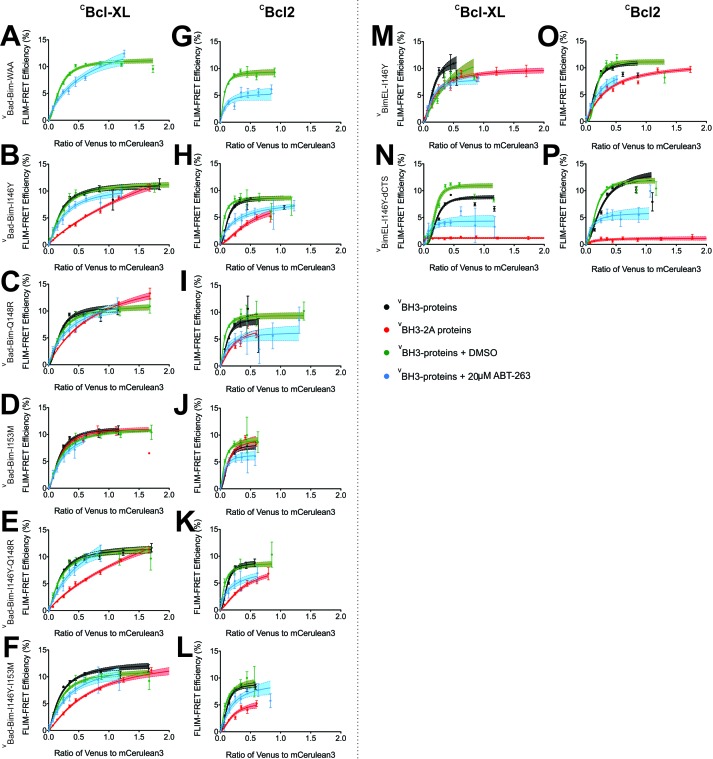
The h0 and h1 residues in the Bim BH3 region contribute to the resistance of Bcl-XL:Bim and Bcl-2:Bim complexes to ABT-263.(A–L) Binding of VBad-Bim chimeric proteins to CBcl-XL (left) and CBcl-2 (right) in MCF-7 cells. The VBad-Bim chimeric proteins are comprised of VBad with the BH3 region replaced with the corresponding region from Bim. Additional point mutations in the Bim BH3 region are indicated to the left of each pair of panels. (M–P) Impact of I146 on the binding of VBimEL or VBimEL-dCTS to CBcl-XL (left) and CBcl-2 (right) in MCF-7 cells. Additional point mutations in VBimEL are indicated to the left of each pair of panels. The binding curves illustrate the extent of binding of untreated (black) and DMSO treated (green) controls, cells treated with 20 μM ABT-263 (blue) or additional BH3-2A mutation (red). Data points in FLIM-FRET binding curves correspond to the average FLIM-FRET efficiency for binned data (20 < cells/bin < 3,000). Error bars, SEM; shadowed area, 95% confidence interval for the best fit of the model to the data.10.7554/eLife.37689.026Figure 6—figure supplement 1—source data 1.Source data fitted to a Hill equation to determine the extent to which residues in the Bim BH3 region contribute to the resistance of Bcl-XL:Bimand Bcl-2:Bim complexes to ABT-263.